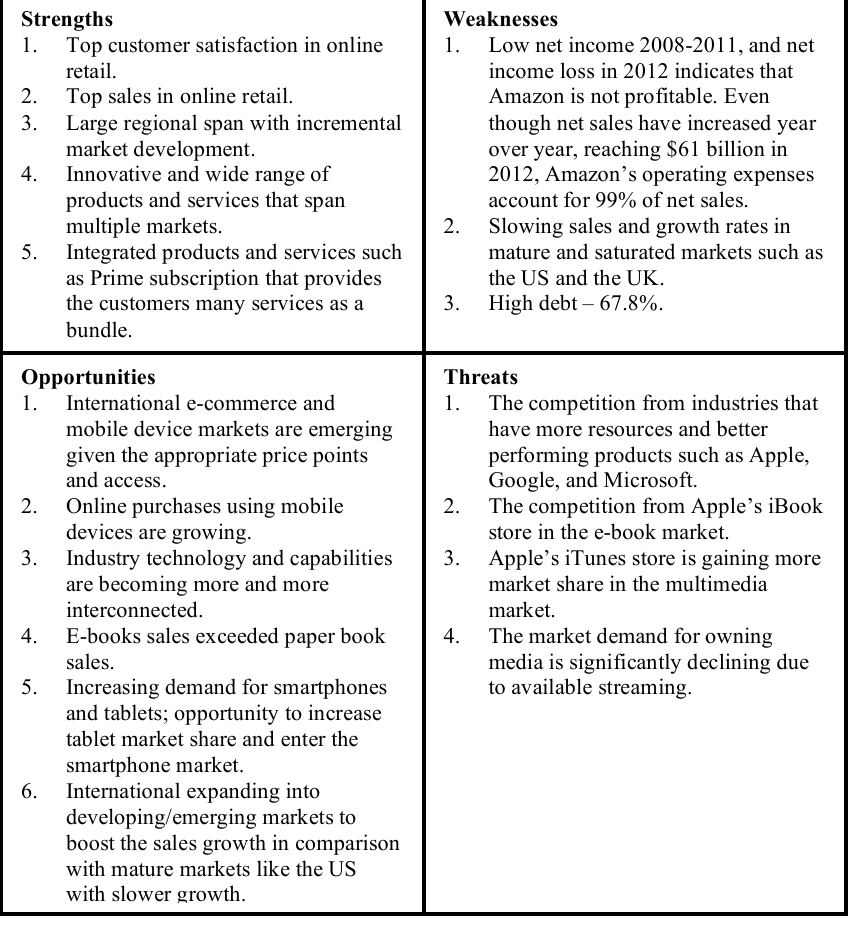
Fig. 6. Amazon SWOT